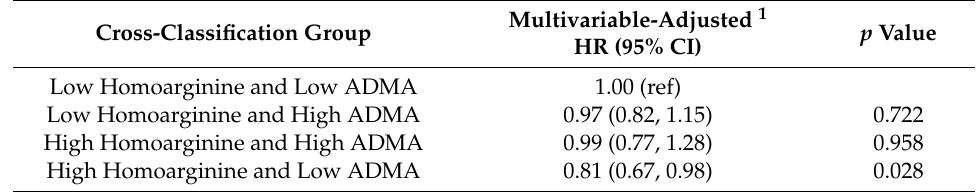
Table 4. Association of cross-classification groups of plasma homoarginine and ADMA concentrations with risk of all-cause mortality.